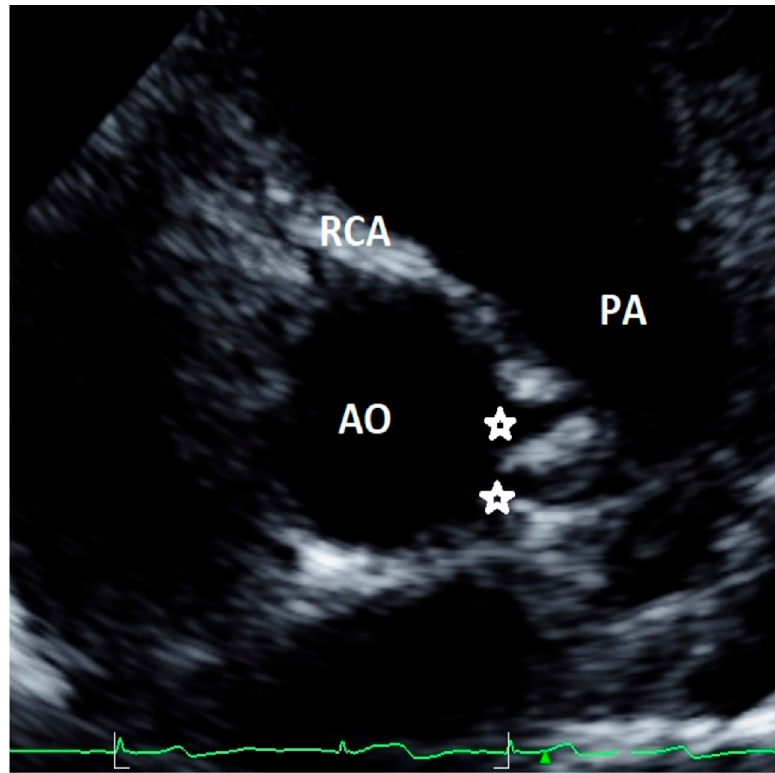
Figure 2. Asymptomatic 13-year-old boy evaluated with negative stress testing for murmur at preparticipation evaluation for sports competition. Parasternal short-axis view at the level of aortic root showing separate origins of circumflex (CFx) and left descending artery (LAD).